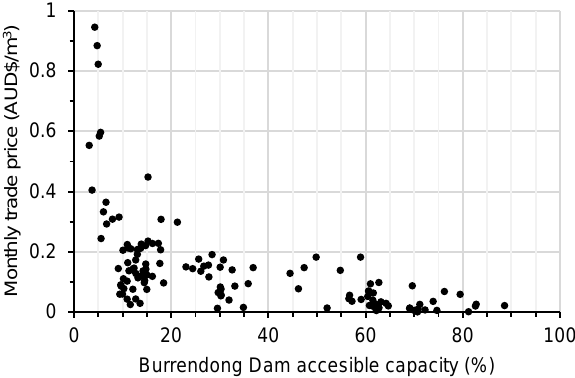
Figure 3. Mean monthly water allocation trade price in the Macquarie River region in relation to average storage level in Burrendong Dam, Jul 2009 to Jan 2020.